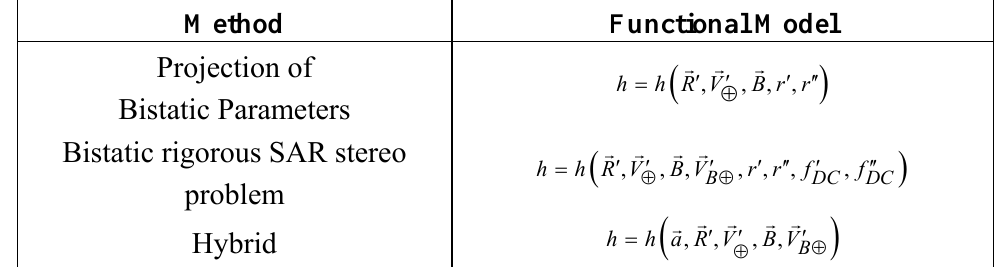
Table 3. Functional models of proposed monostatic-bistatic methods for terrain relief